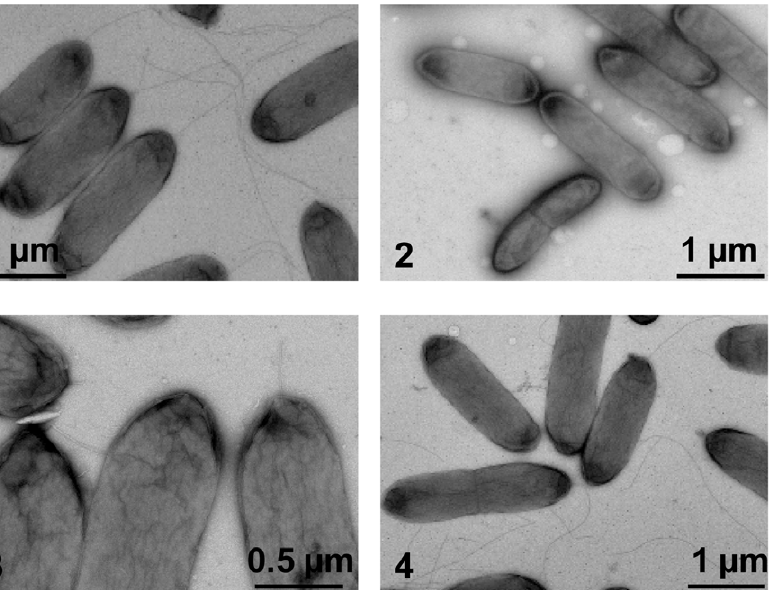
Figure 3. Transmission electron micrographs of S. oneidensis wild type and flagellar mutantstrains. Cells were stained with 1% phophotungstic acid and applied to TEM. 1. The wild type. 2. D flgK , aflagellated. 3. D fliD , truncated filaments. 4. D SO3234 , flagella indistinguishable from that of the wild type.